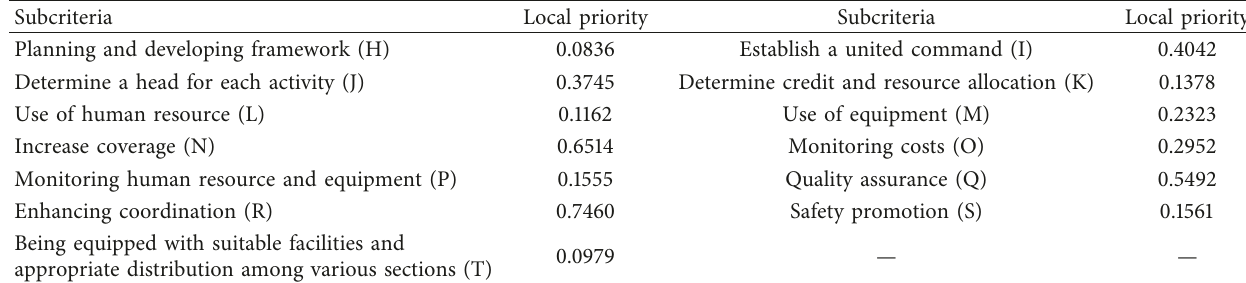
Table 10: Local priority coefficient of subcriteria.